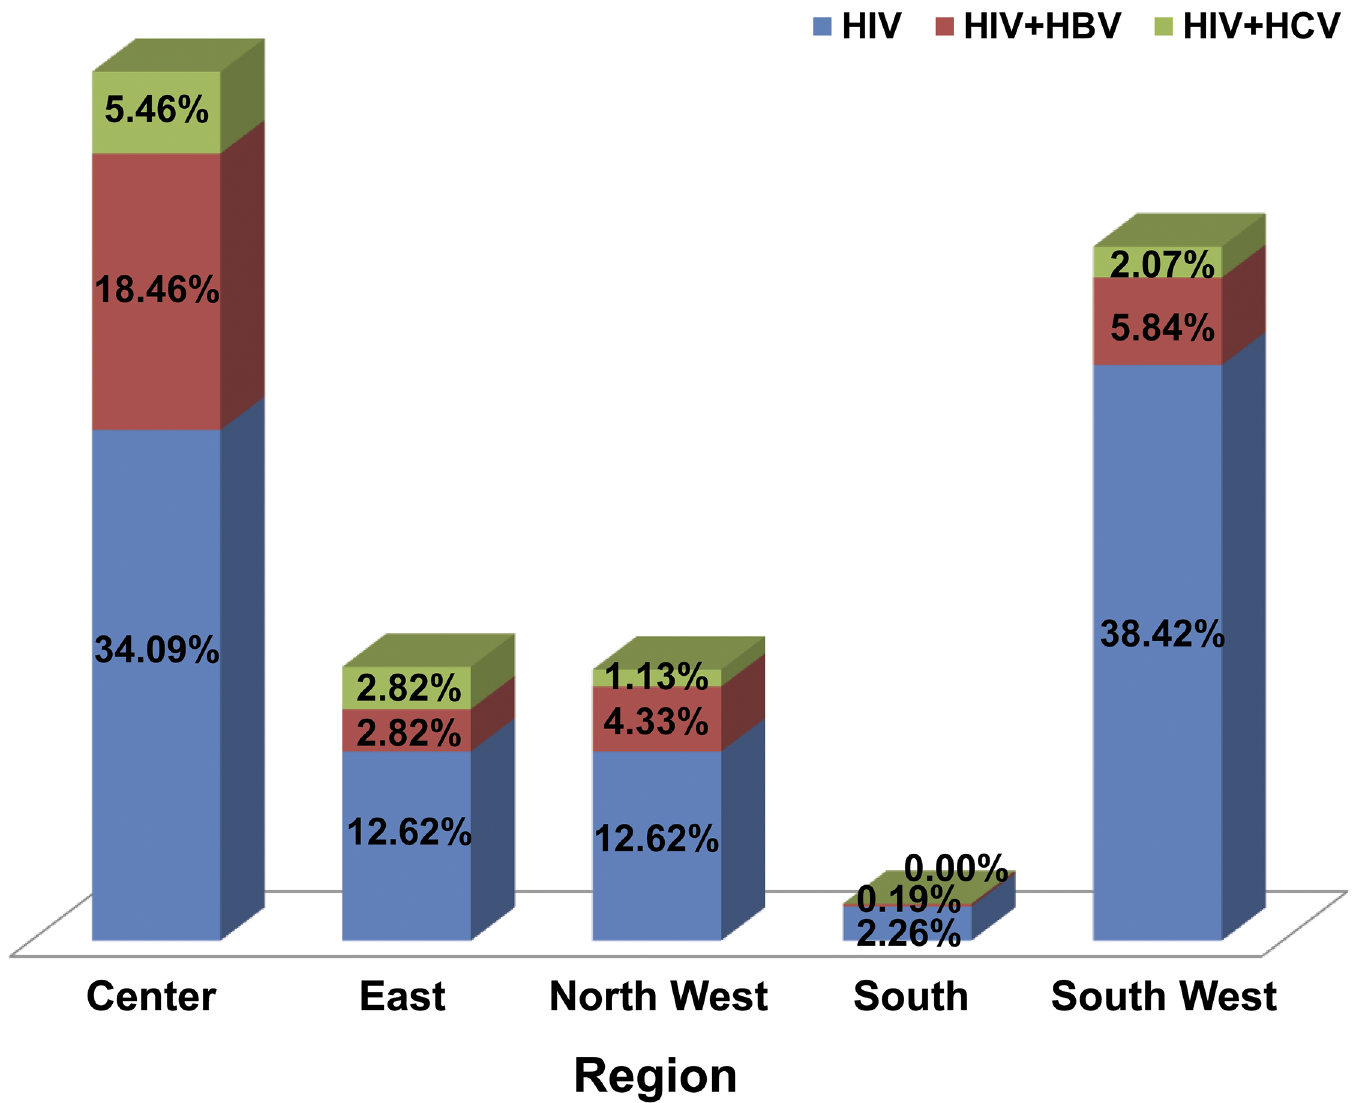
Fig 3. Region-specific prevalence for co-infection with HBV or HCV. Prevalence rates were calculated based on the proportion of study participants at risk of co-infection in a given region.